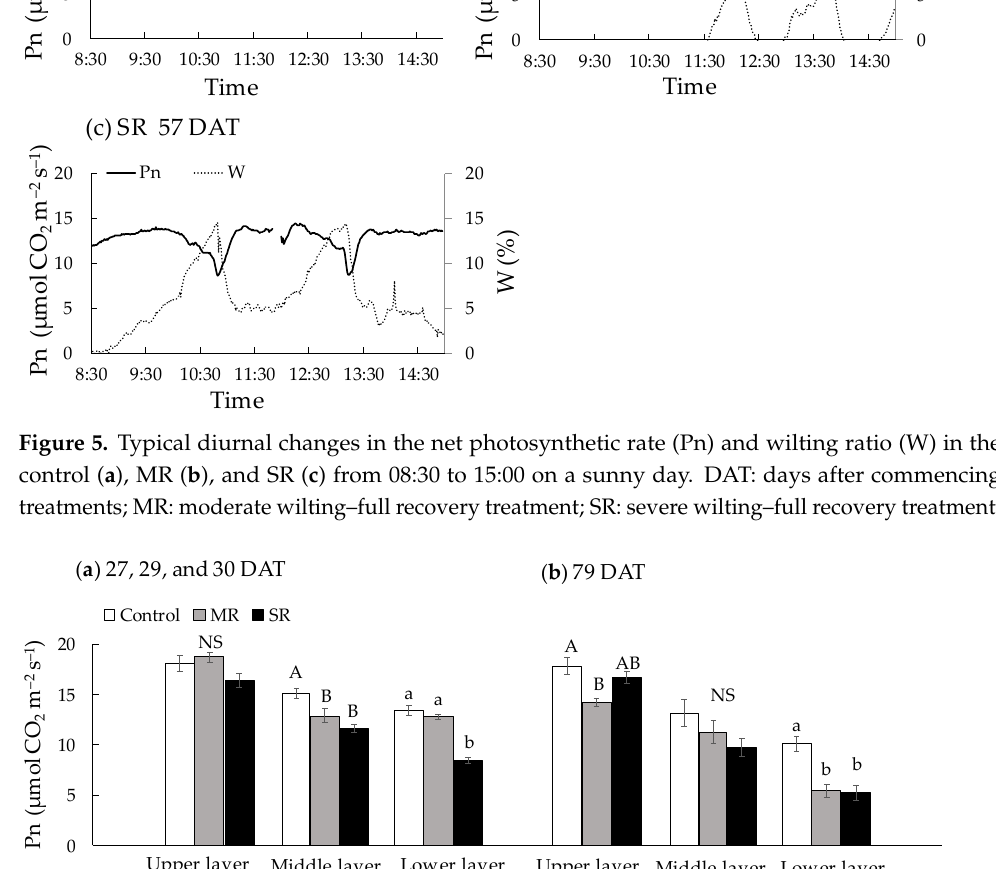
Table 2. Effect of water stress on the growth of tomatoes recorded at 34 and 83 days after com- mencing treatment (DAT).